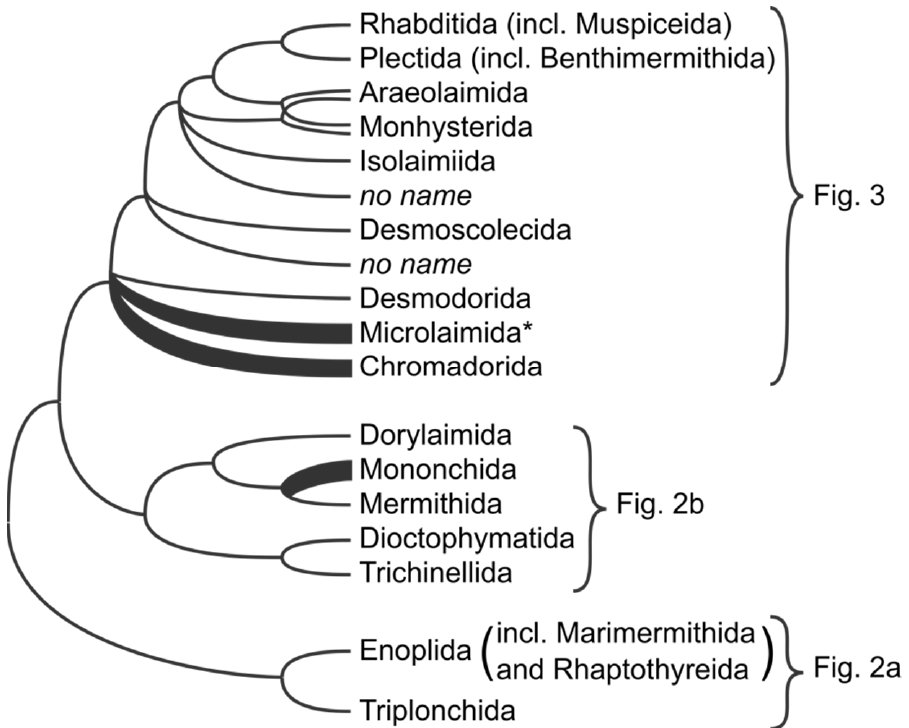
Figure 1. Simplified overview of phylogenetic relationships between different orders of the phylum Nematoda, based on the combination of phylogenomic and 18S rRNA-based analyses. Taxa marked with “*” were not included in the classification of De Ley and Blaxter [2,3] but have been introduced or used in subsequent publications. “ no name ” refers to distinct well-supported lineages that were formally classified in one of the existing orders but phylogenetically do not belong to those; based on the current topology they should be given a status of new orders. Phylogenetic relationships within the order Triplonchida (Figure 2a) are not fully re- solved based on the 18S rRNA data and do not fully agree with the classification proposed by De Ley and Blaxter [3]. The basal polytomy splits into four clades (E2 in Figure 2a): (1) Onchulidae so far represented by a single sequenced species; (2) clade consisting of Bas- tianiidae (placed in the order Plectida [3]) and Prismatolaimidae, weakly supported in some analyses (E3 in Figure 2a); (3) clade with Tobrilidae being nested within the paraphyletic Tripylidae (E5 in Figure 2a); (4) clade including Trichodoridae, Odontolaimidae (placed in the order Plectida [3]) and polyphyletic Diphtherophoridae (E4 in Figure 2a) [12,19–22] (Figure S1). The monophyly of clade uniting Bastianiidae and Prismatolaimidae (E3 in Figure 2a) receives support from morphological data—both share the same unique shape of supplements and the amphid. The presence of protrusible odontostyle and male sup- plementary organs distributed along the ventral side of anterior body region are the two characters that support the monophyly of the clade Diphtherophoridae and Odontolaimi- dae and Trichodoridae (E4 in Figure 2a). The interrelationships between Tobrilidae and Tripylidae (E5 in Figure 2a) remain unresolved both from the molecular [19,20] and morpho- logical points of view, in the latter case due to the existence of recently described Neotripyla (family Neotripylidae), which possesses features intermediate between two families